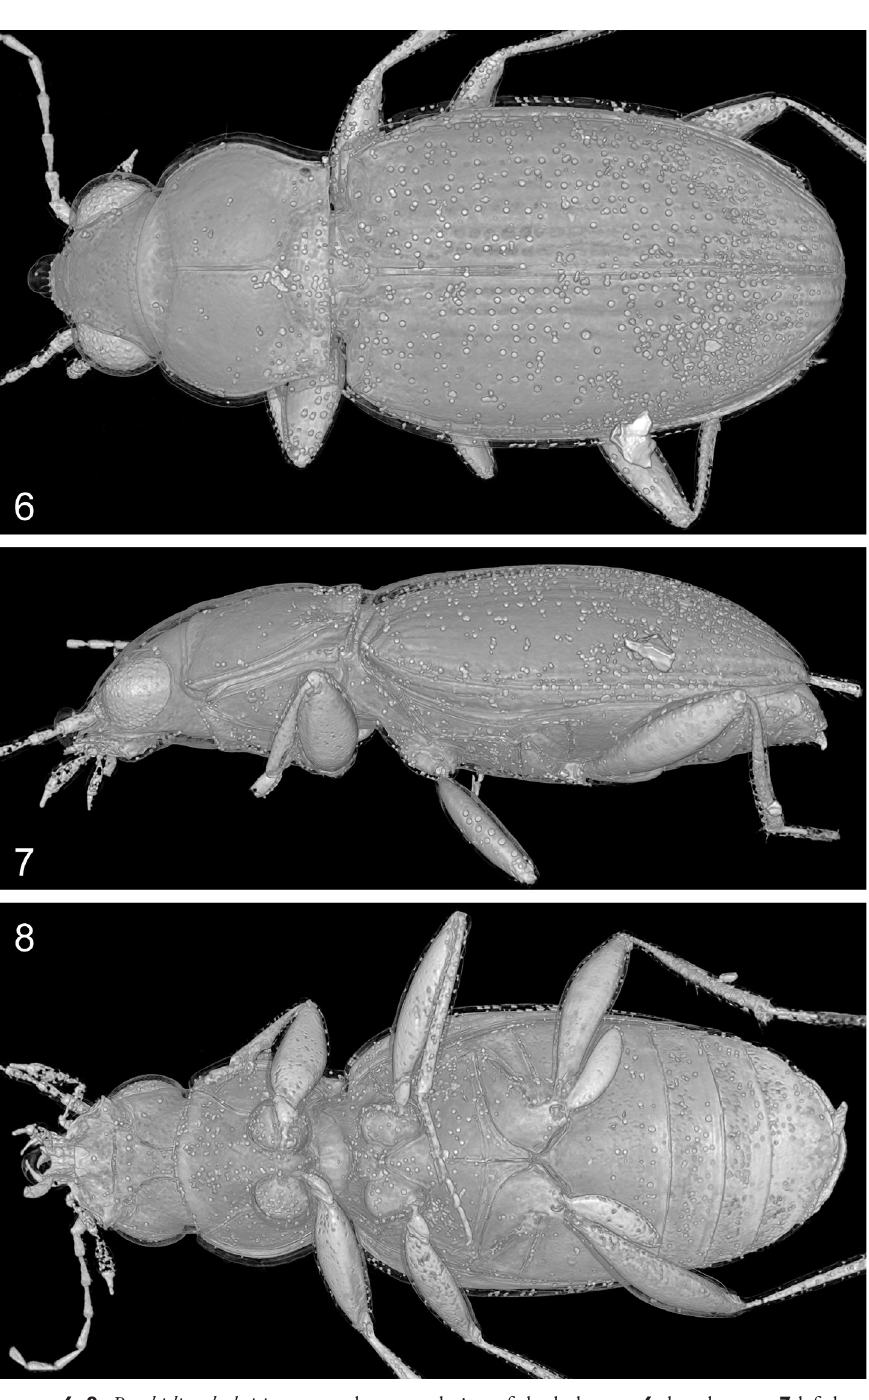
Figures 6–8. Bembidion bukejsi sp. n., volume rendering of the holotype. 6 dorsal aspect 7 left lateral aspect 8 ventral